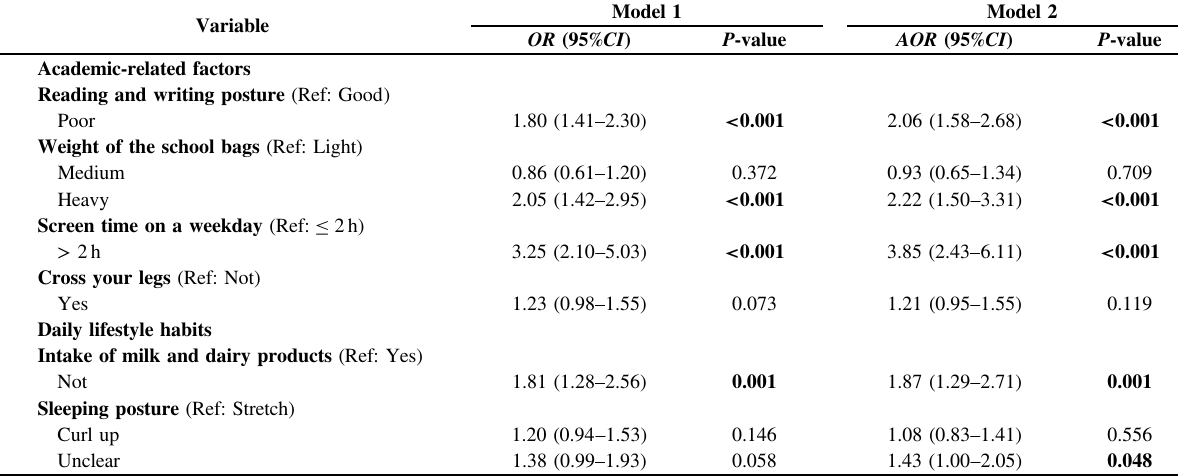
Table 3 Multivariable logistic regression analysis with signi fi cant